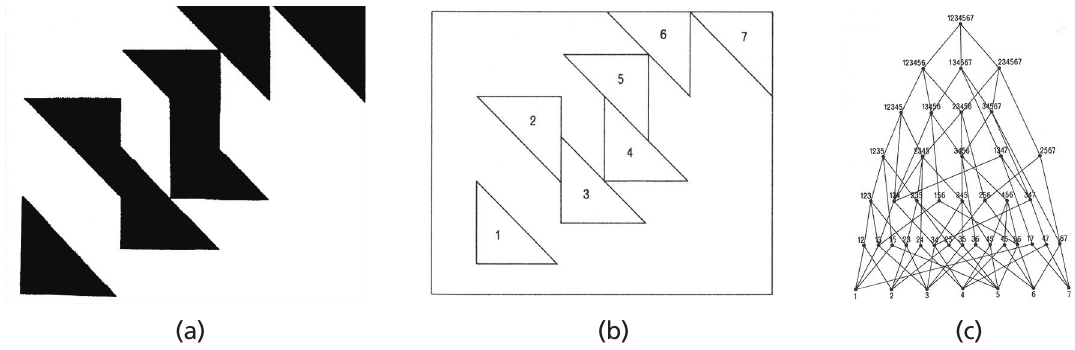
Figure 3. Overlapping Subsets in a painting by Simon Nicholson. ( a ) painting; ( b ) outline of main figures; ( c ) sketch of overlaps. Alexander writes: “Triangles 3 and 5 form a unit because they work together as a rectangle; 2 and 4 because they form a parallelogram; 5 and 6 because they are both dark and pointing the same way; 6 and 7 because one is the ghost of the other shifted sideways; 4 and 7 because they are symmetrical with one another; 4 and 6 because they form another rectangle; 4 and 5 because they form a sort of Z; 2 and 3 because they form a rather thinner kind of Z; 1 and 7 because they are at opposite corners; 1 and 2 because they are a rectangle; 3 and 4 because they point the same way as 5 and 6, and form a sort of off-centre reflection; 3 and 6 because they enclose 4 and 5; 1 and 5 because they enclose 2, 3 and 4. I have only listed the units of two triangles. The larger units are even more complex. The white is more complex still and is not even included in the diagram because it is harder to be sure of its elementary pieces.” Source: { A City is Not a Tree }